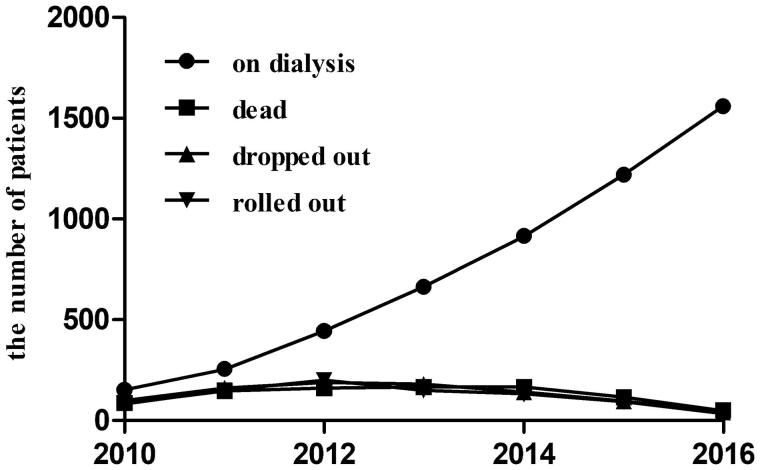
The prevalence of patients on peritoneal dialysis. From 2010 to 2016, the numbers of patients on dialysis were 154, 256, 446, 664, 916, 1220 and 1561, respectively. The numbers of patients who dead were 88, 148, 161, 165, 165, 116 and 50, respectively. The numbers of patients who dropped out were 101, 163, 190, 180, 142, 97 and 42, respectively. The number of patients who rolled out were 83, 149, 201, 150, 133, 94 and 36, respectively.